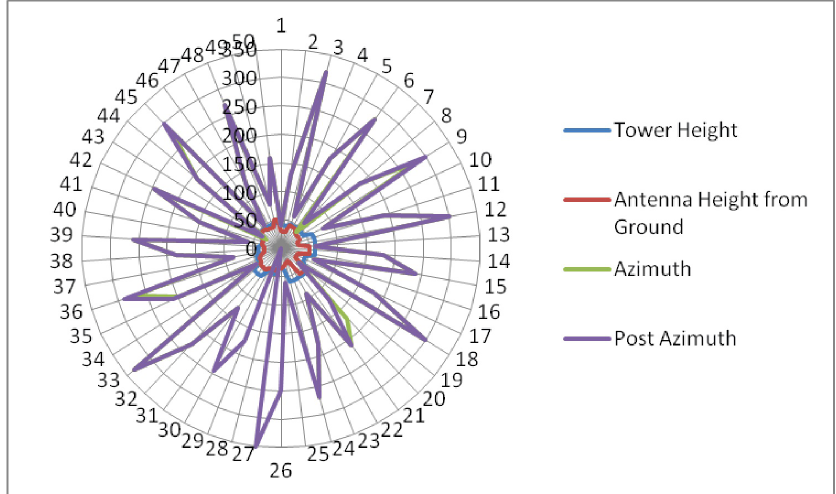
Figure 8. Comparison of effects of azimuth and post-azimuth tilt with respect to tower and antenna heights calculated for the test